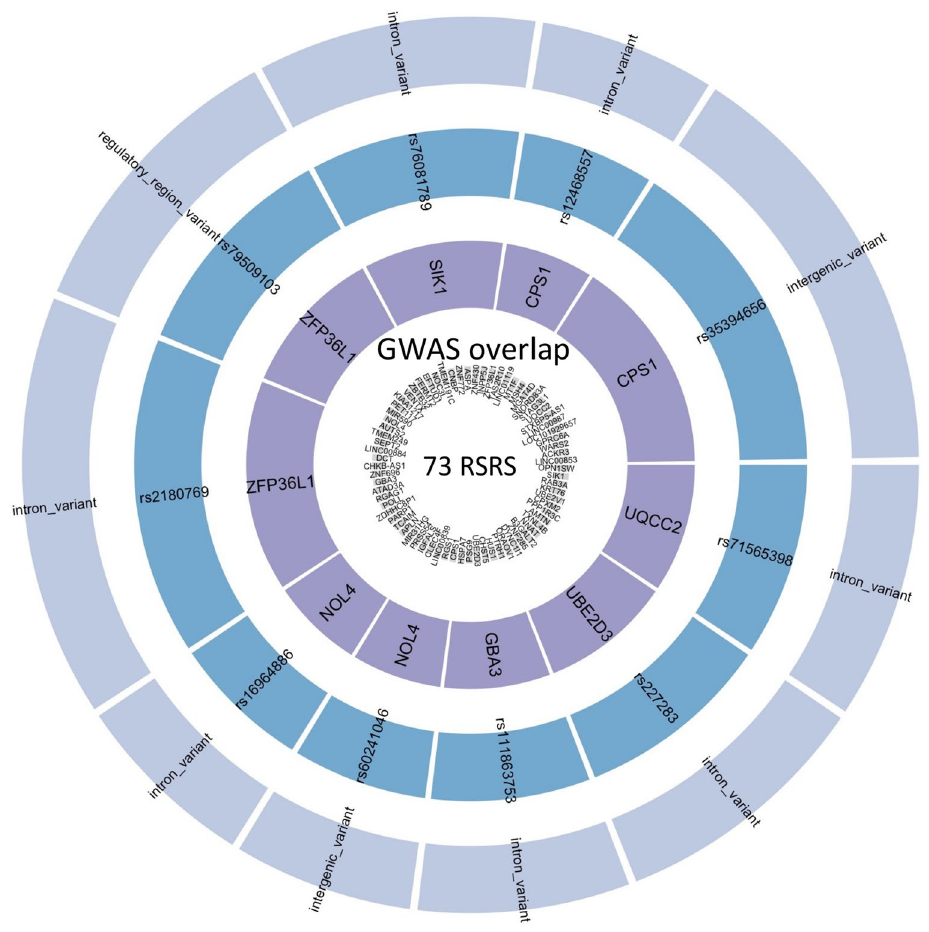
Figure 6. The overlap between the 73 RSRS genes and asthma genome wide association study catalog. The sector width for the SNP is proportional to the − log10 (adjusted p value) corresponding to each